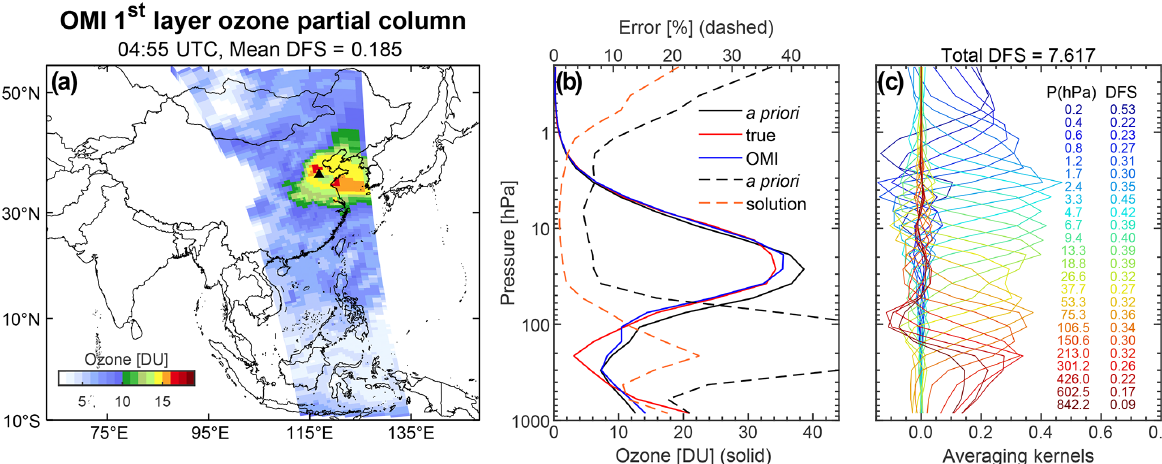
Figure 2. Same as Fig. 1 but from simulated OMI retrievals at 04:55UTC on 16 June 2020.